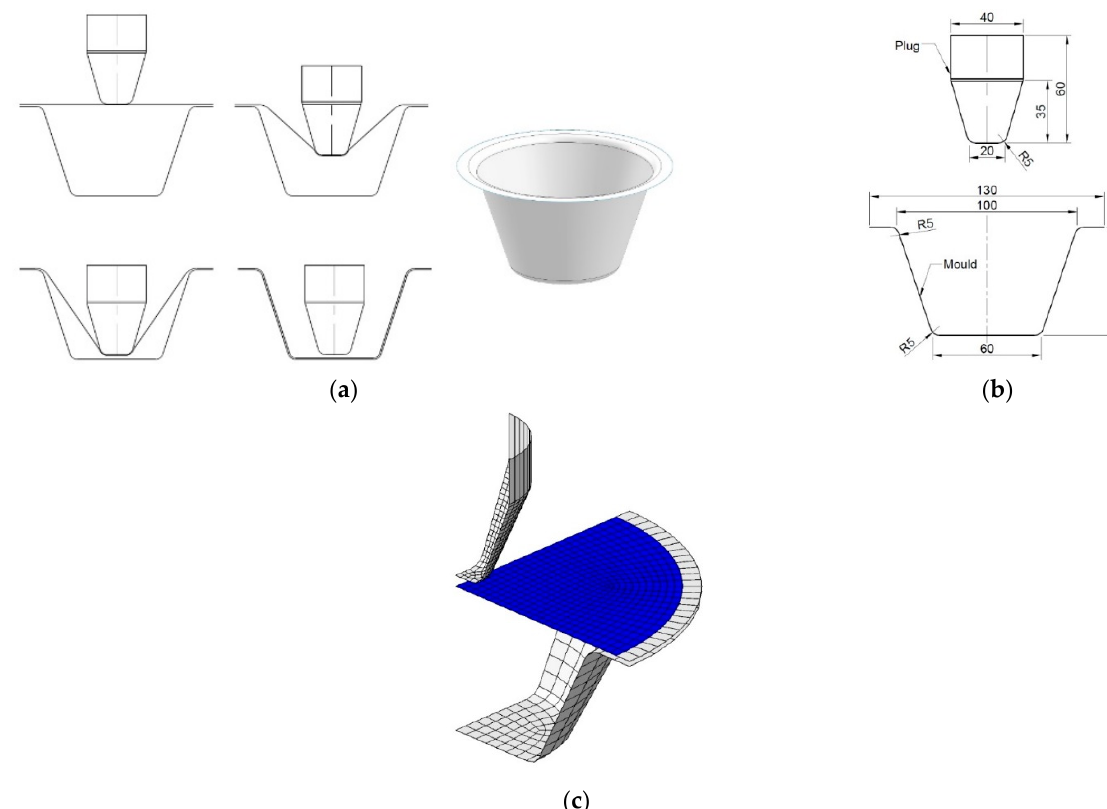
Figure 1. Plug-assist thermoforming. ( a ) Forming process, ( b ) design of plug and mould, ( c ) finite element model.